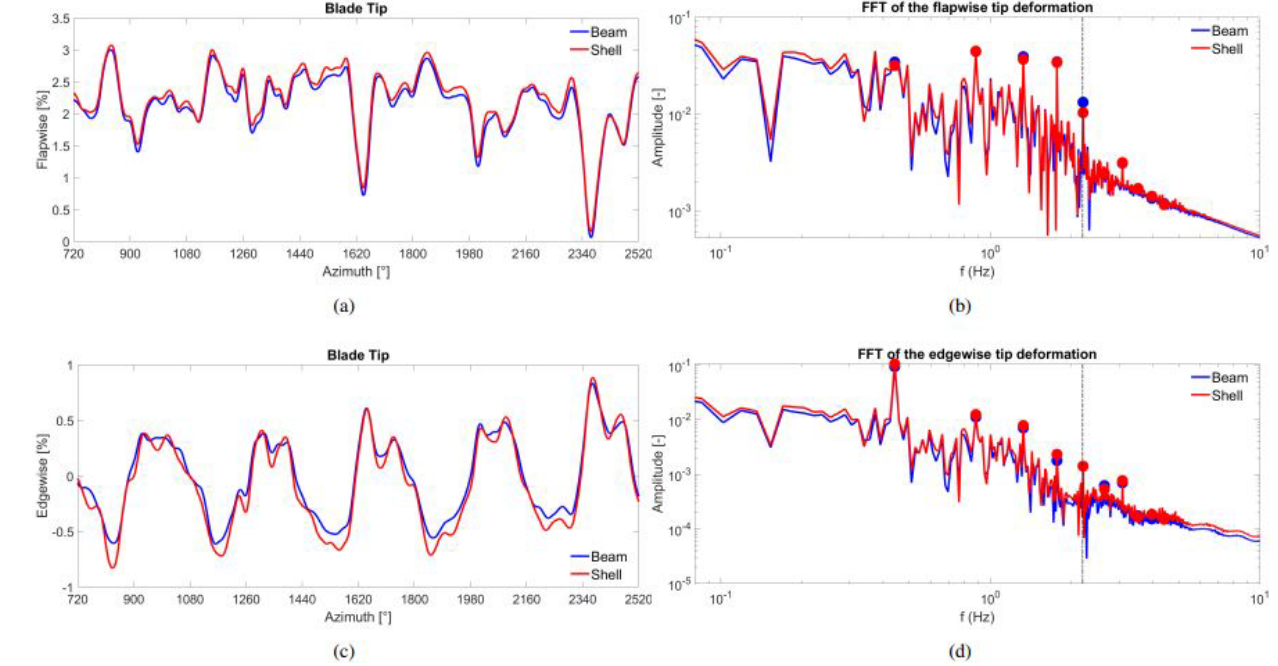
Figure 8. Flapwise (a) and edgewise (c) blade tip deformation over three revolutions, with comparison of beam and shell coupling. Pan- els (b) and (d) show the FFT over a 1min simulation. A 1D moving-average filter has been applied for clearness. Dotted vertical lines are plotted at the first flapwise and edgewise eigenfrequency of the blade,